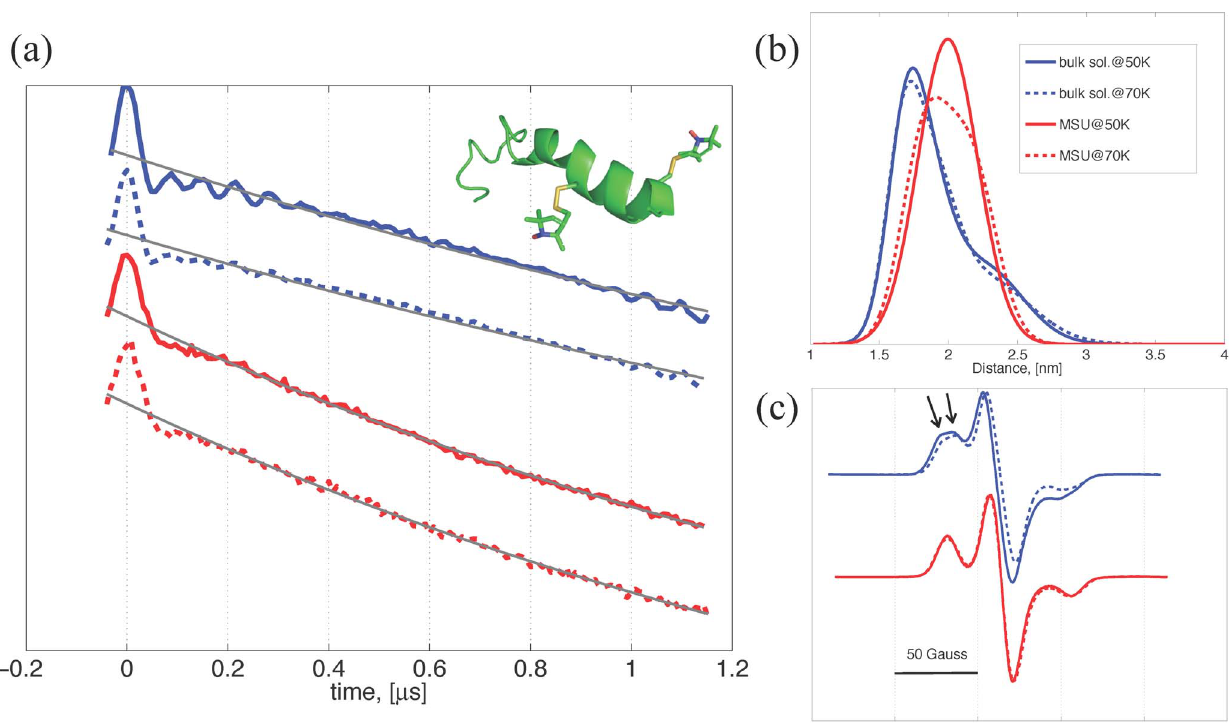
Figure 2. Determination of the n3 a -d structure. (a) The time-domain DEER signals of the studied conditions. The gray lines represent the exponential baselines that best fit the data. Inset shows a ribbon model of the n3 a -d derived from NMR data (PDB code: 1M25). (b) The P(r) distributions extracted from the time-domain DEER data by the Tikhonov regularization analysis. The average distances ( , 2.0 nm) are consistent with the expectation. (c) The cw-ESR spectra of the n3 a -d. The spectra of the bulk solution studies are characterized by a broader linewidth and the spectral heterogeneity (indicated by arrows) as compared to the spectra of the nanochannel studies.